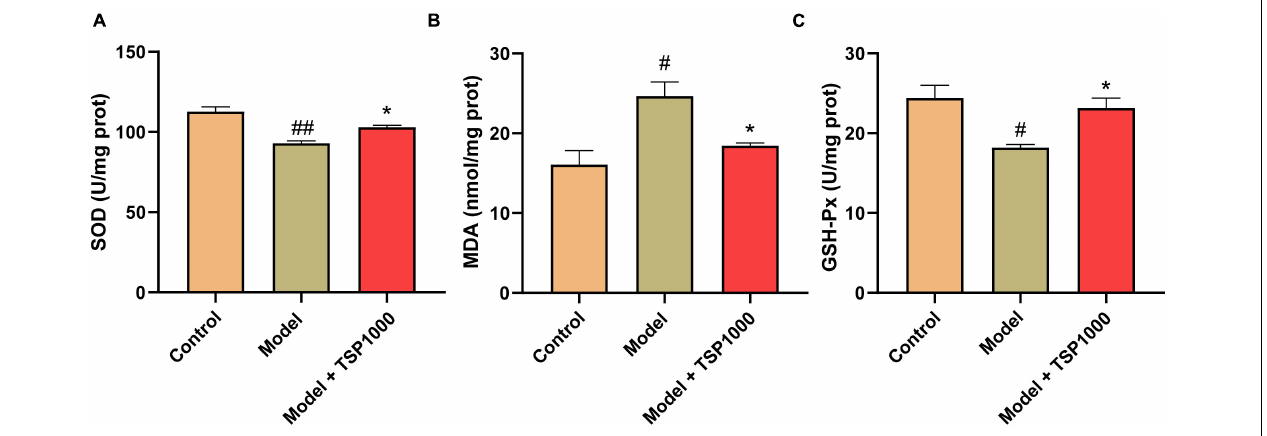
FIGURE 3 | The effects of TSP on oxidative stress. The SOD activity (A) , MDA content (B) , and GSH-Px (C) levels were tested in the hippocampus. All data were expressed as mean ± SEM ( n = 5). # P < 0.05, ## P < 0.01 vs. Control group; * P < 0.05 vs. Model group.